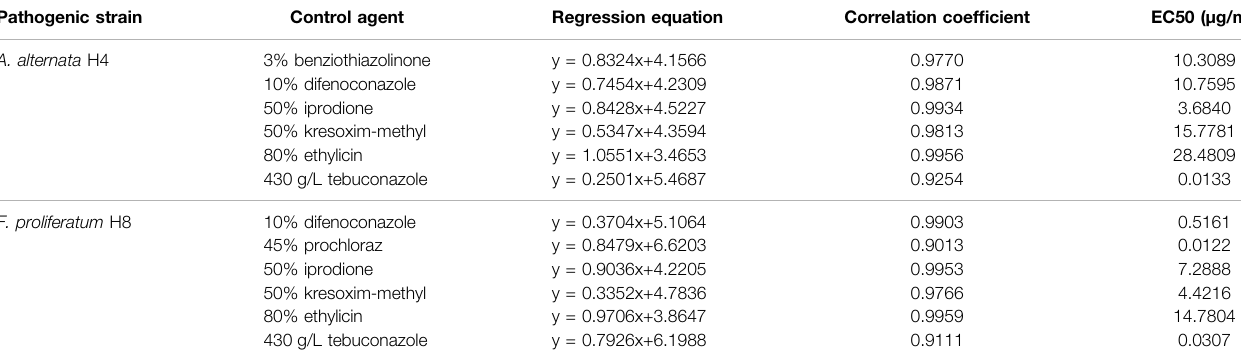
TABLE 4 | Determination of the ef fi cacy of screened fungicides to A. alternata H4 and F. proliferatum H8. Pathogenic